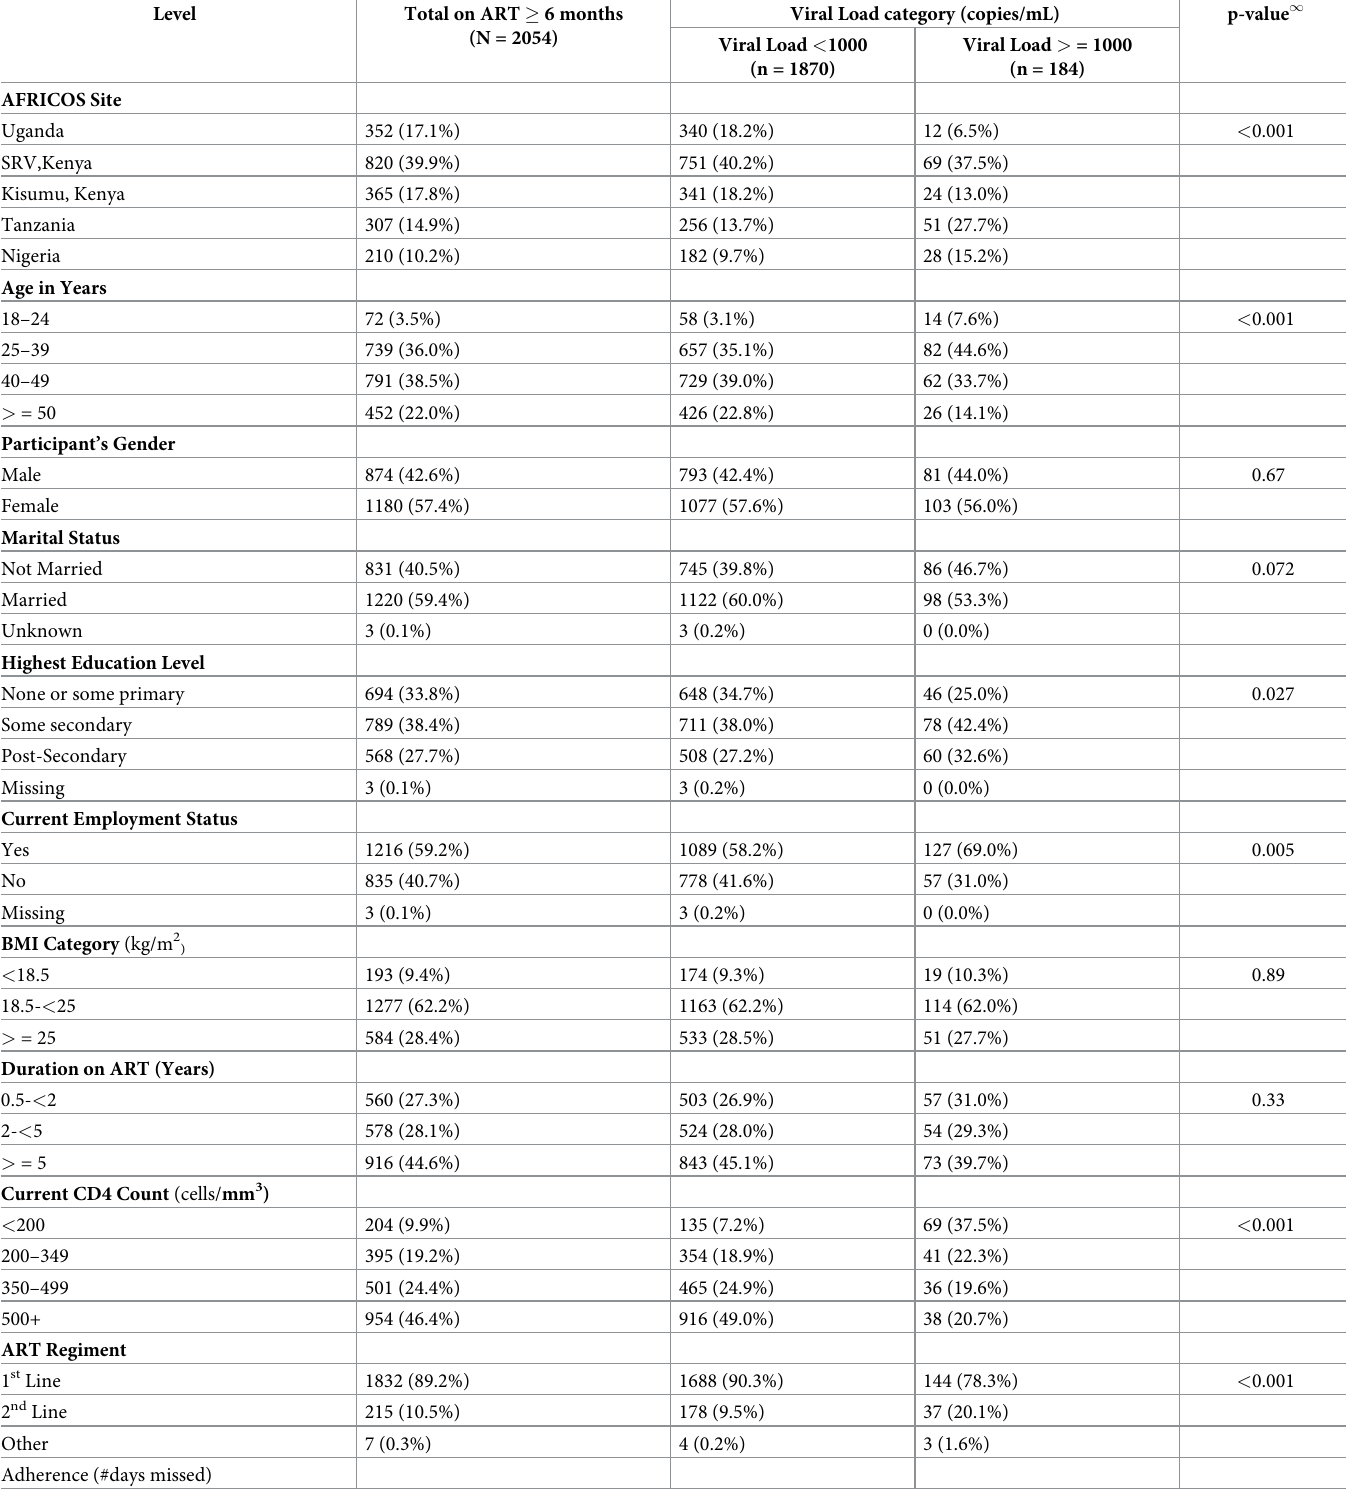
Table 1. Socio-demographic and clinical characteristics of 2054 HIV infected AFRICOS-participants by viral load category at the most recent